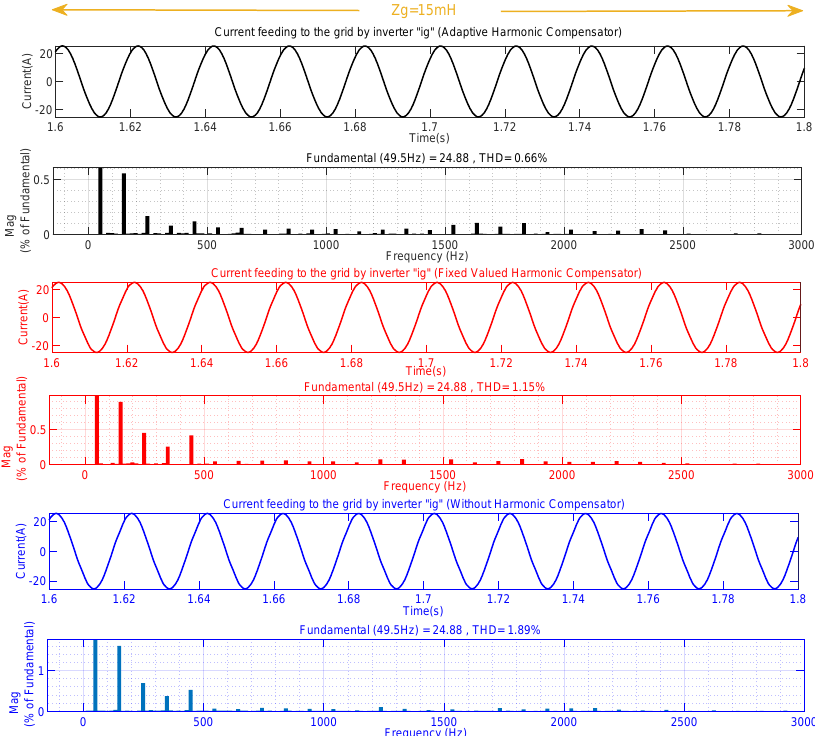
Figure 19. Results of proposed adaptive harmonic compensator, fixed value harmonic compensator and without harmonic compensator when grid frequency is 49.5